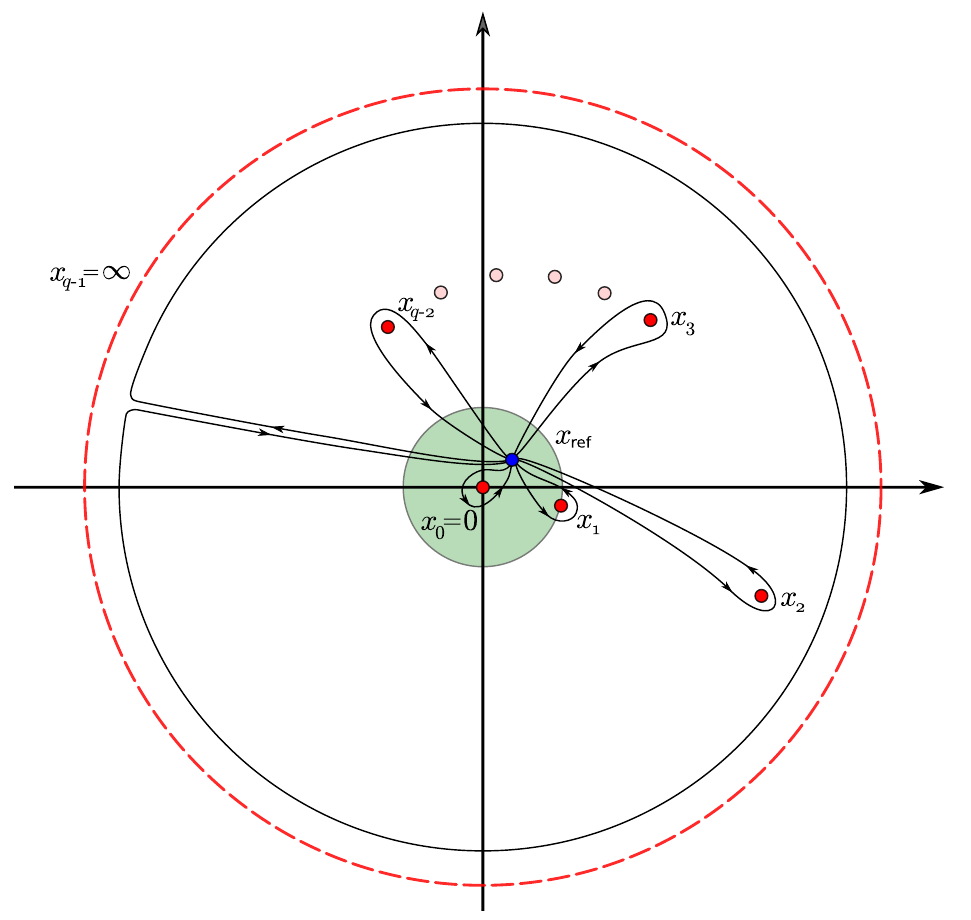
Figure 1 . Paths for the analytic continuation and the calculation of the monodromies for a differential operator with q regular singular poles, one of which at zero and one at infinity. The (blue) reference point x has been conveniently chosen in the (green) disc D ref